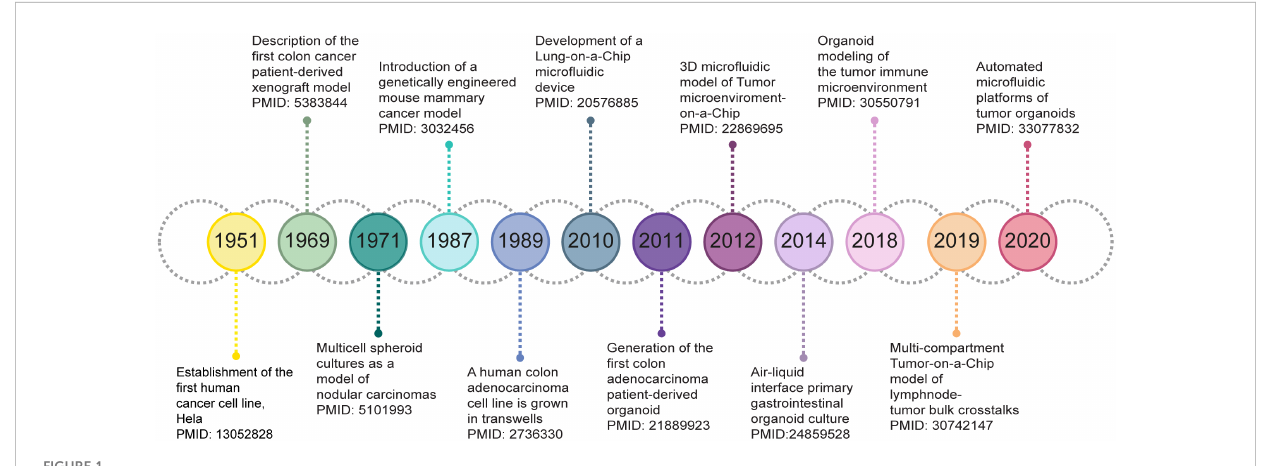
FIGURE 1 Timeline of milestones in the development of 3D cancer